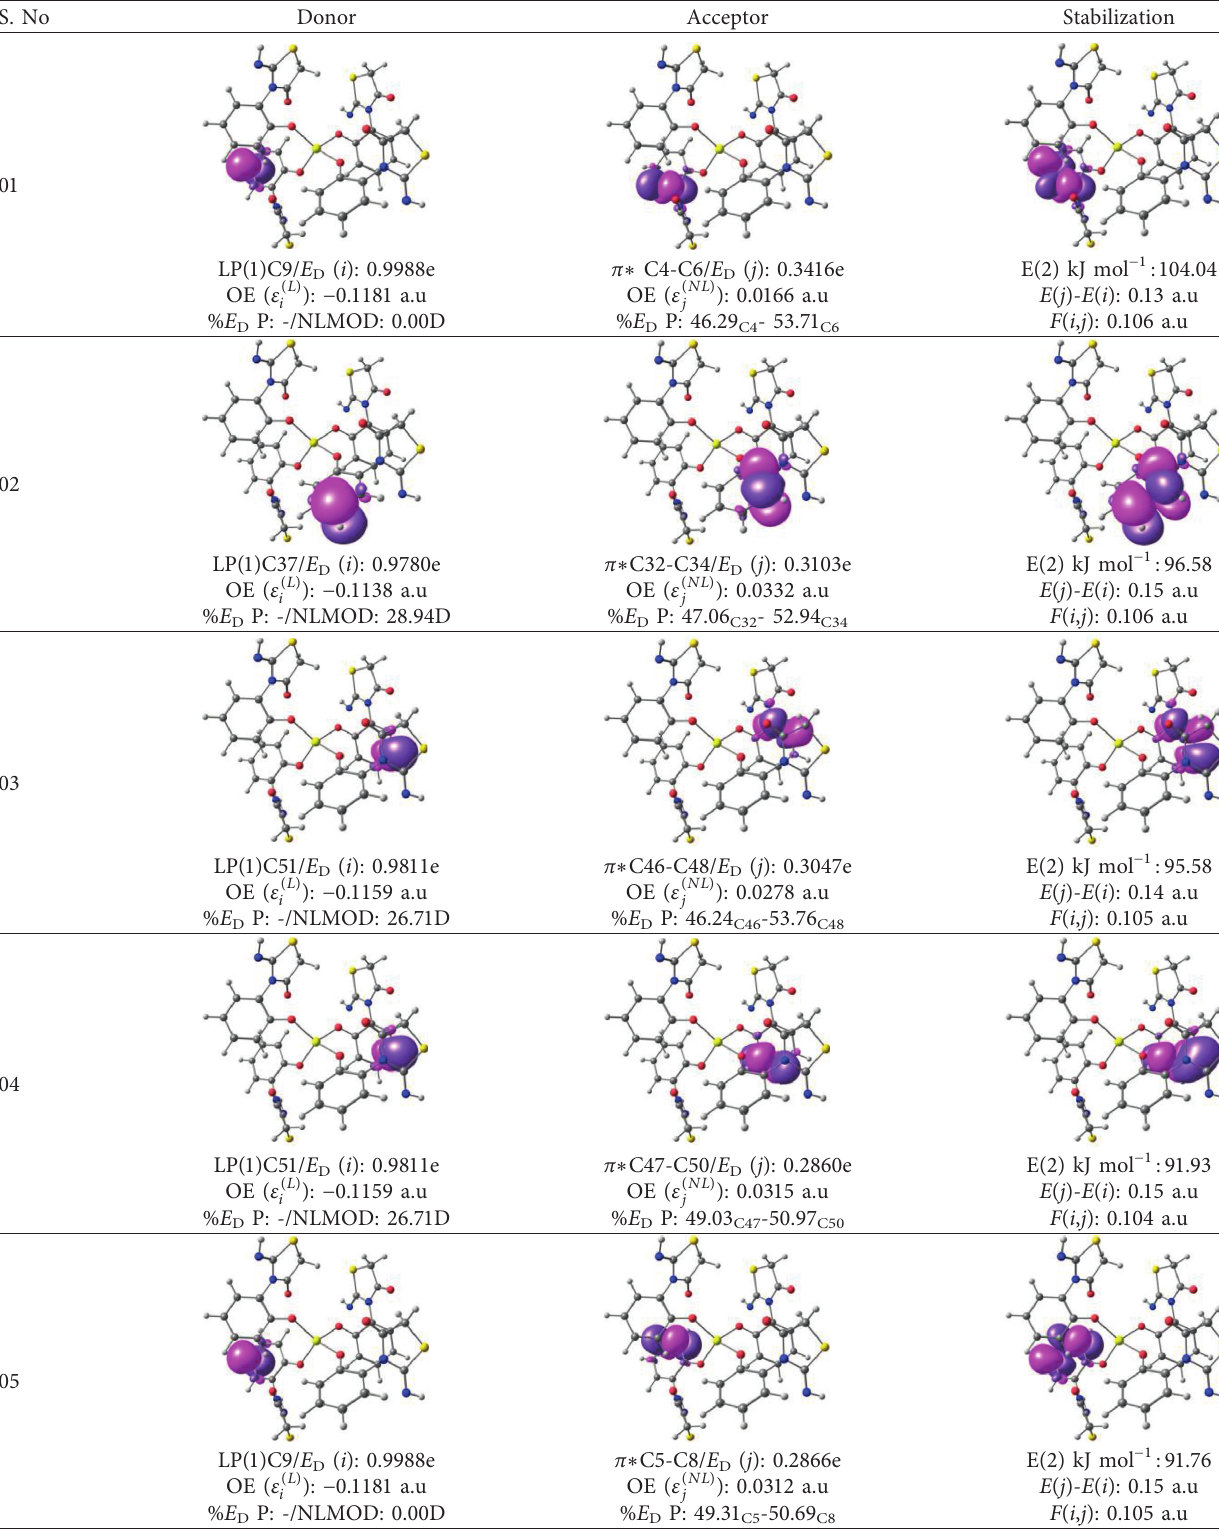
Table 8: NBO profile of